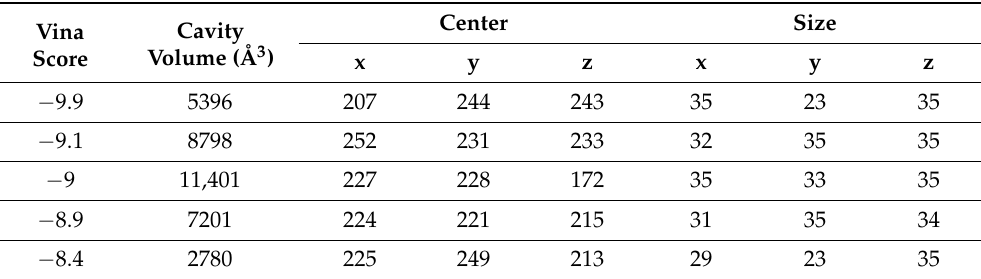
Table 2. Binding mode and the related cavity size based on the results of CB-Dock for EGCG and the receptor of